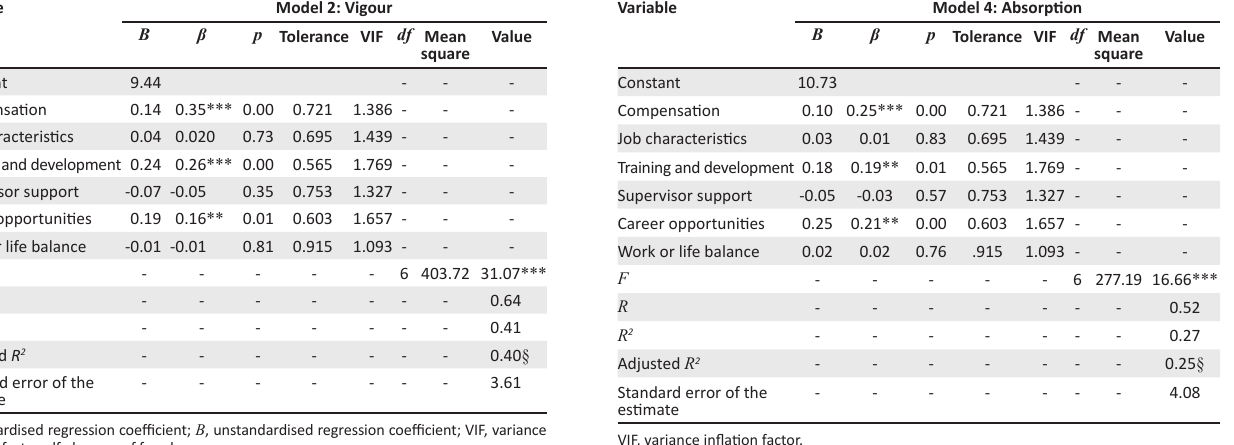
TABLE 5: Multiple regression analysis: Retention Factors Measurement Scale as a predictor of vigour ( N = 278).